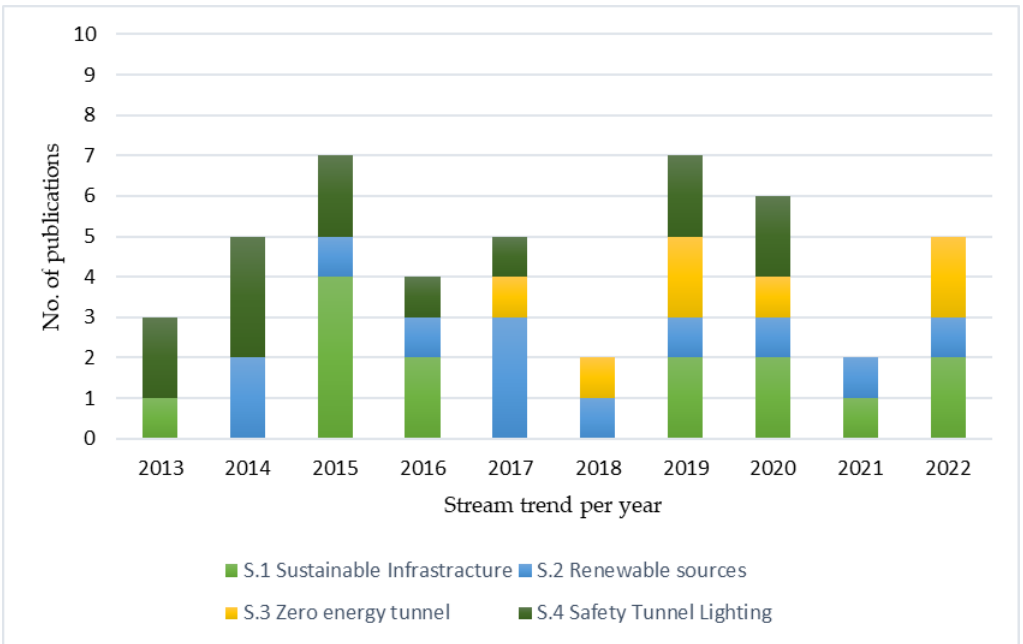
Figure 10. Research trends per year.